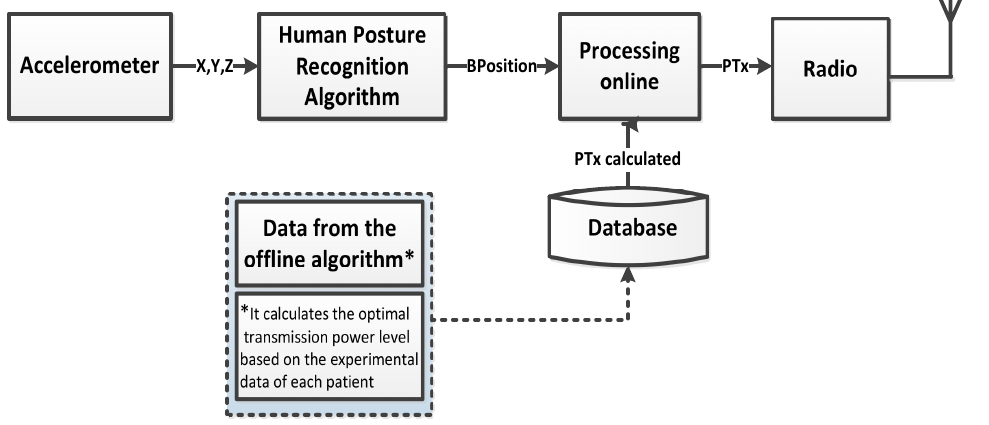
Figure 2. Reactive algorithm for the transmission power